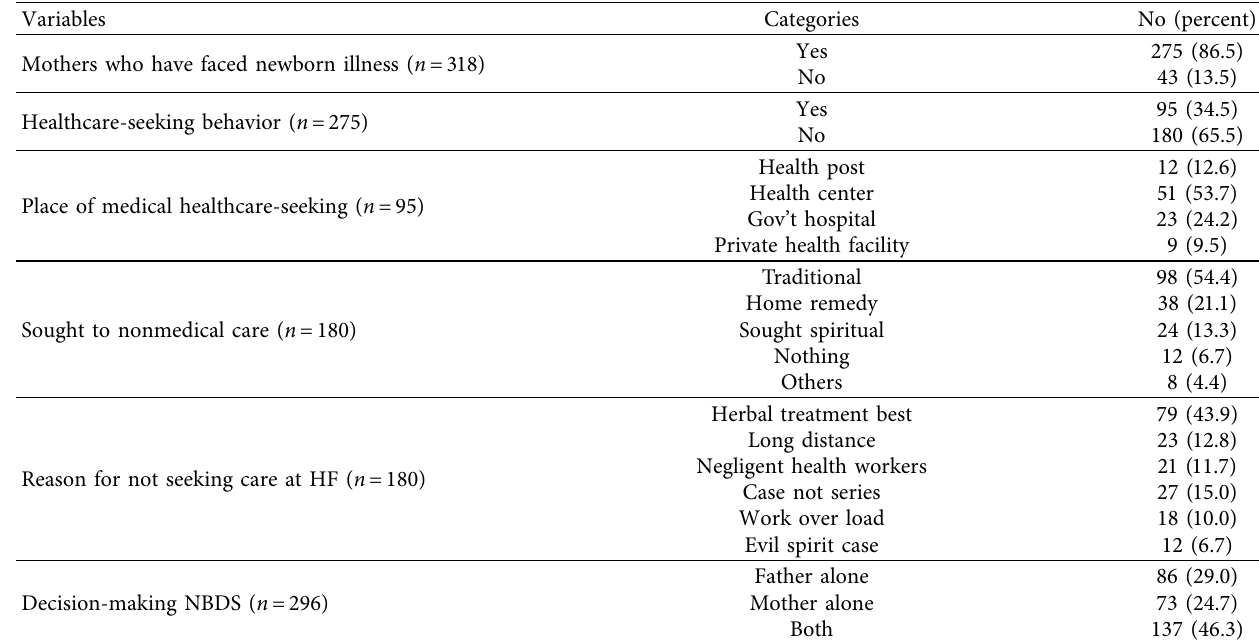
Table 5: Mothers healthcare-seeking behavior in Anlemo district, southern Ethiopia, 2019.